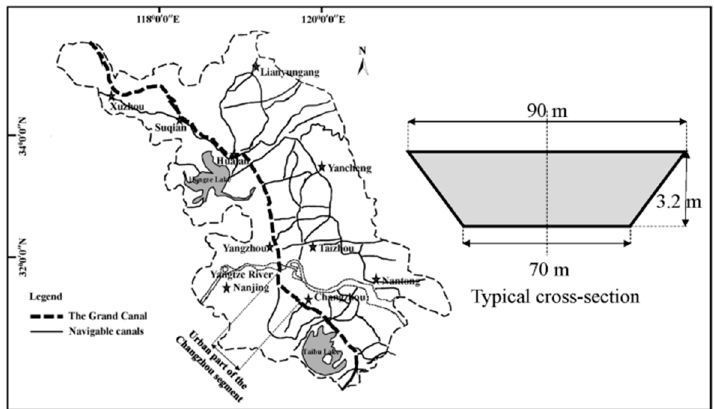
Figure 1. Location of the urban part of the Changzhou segment of the Grand Canal and the typical designed cross-section.